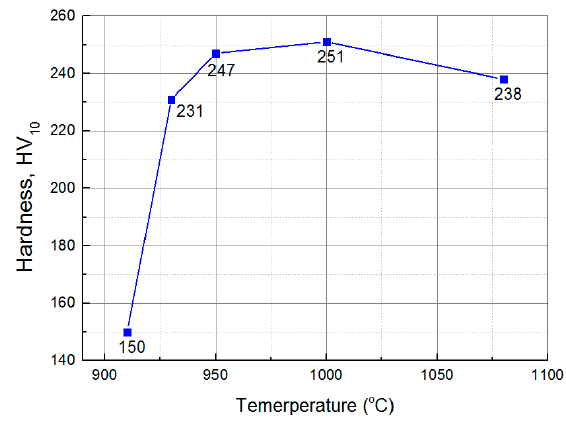
Figure 2. E ff ect of quenching temperature on hardness of material under Figure 2. Effect of quenching temperature on hardness of material under study. Figure 2. Effect of quenching temperature on hardness of material under study.